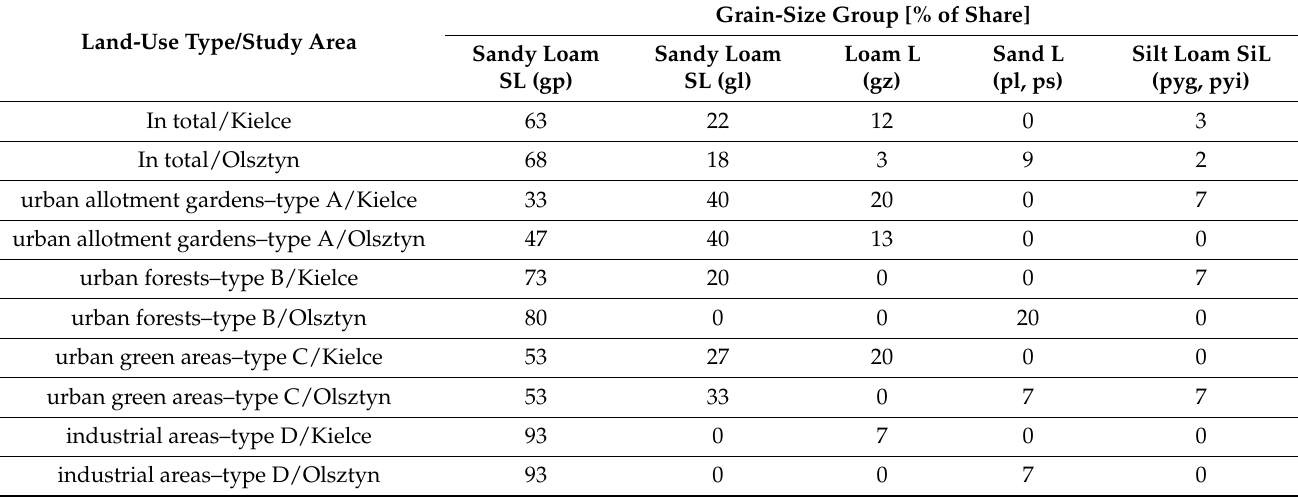
Table 2. List of grain-size groups or texture classes of the studied soils in Kielce and Olsztyn with regard to land-use types distinguished in soil texture classifications (acc. to USDA and PTG